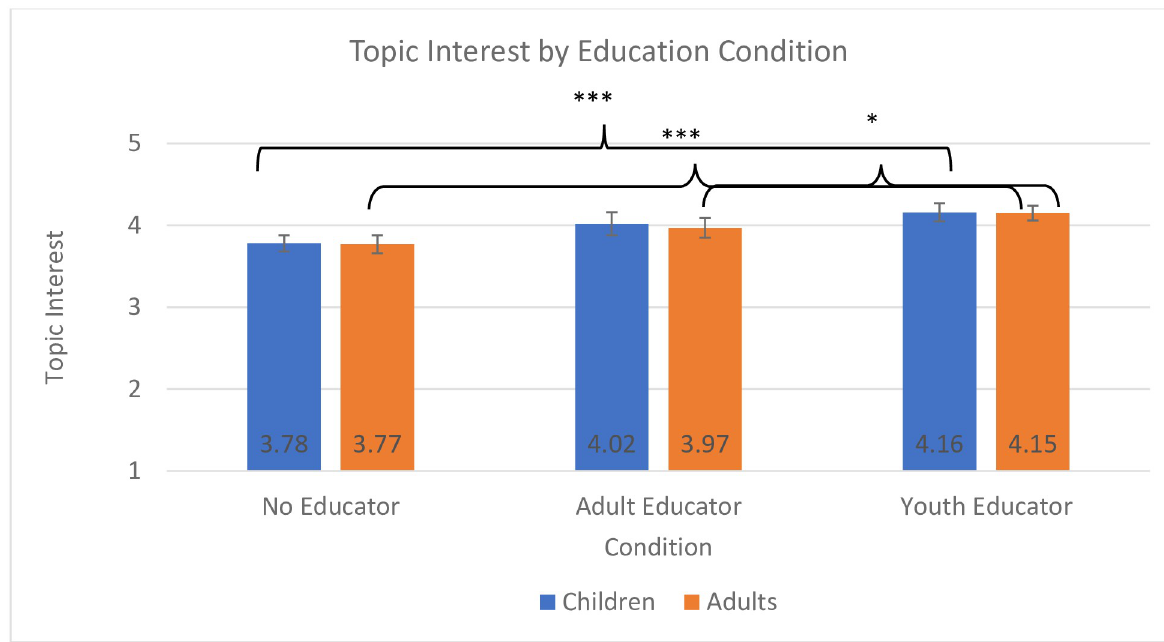
Fig 1. Topic interest by education condition. Analyses for children and adults were conducted separately, but are displayed in one graph for ease of interpretation across analyses; � p < .005, �� p < .01, ��� p < .001.